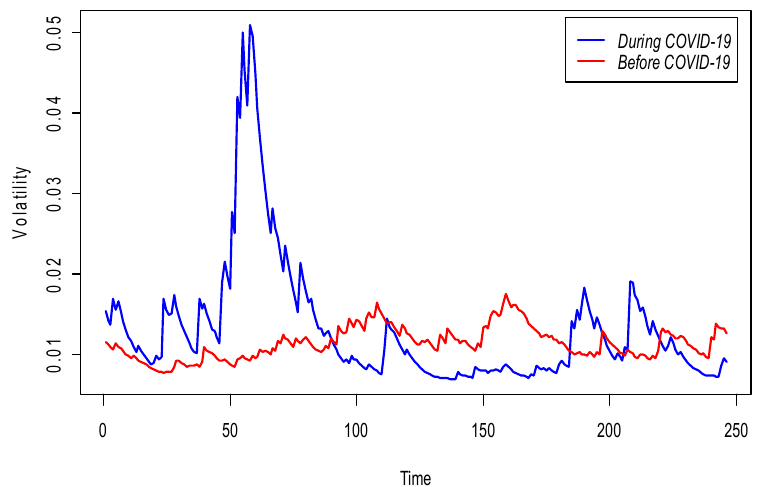
Figure 2. Comparison of estimated volatilities of PSX-100 returns. The pre-pandemic period